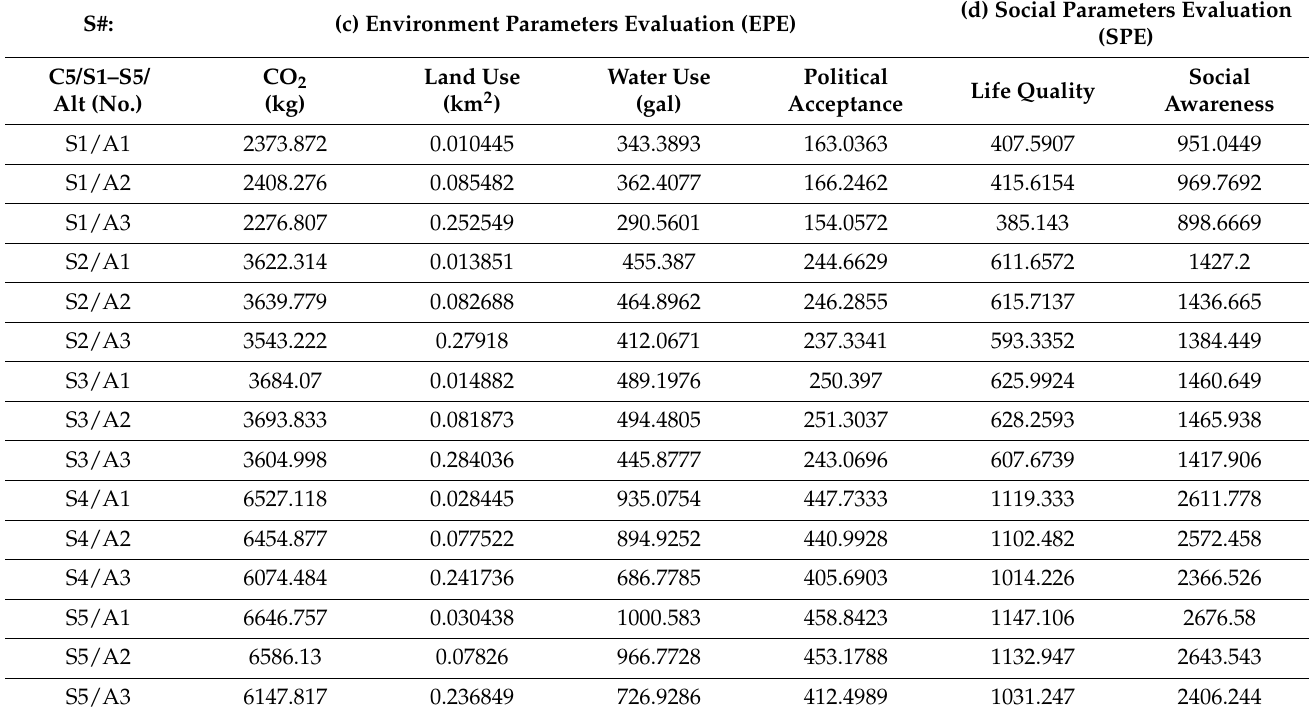
Table 23. EPE/SPE evaluations in C5/S1–S5 for the 75-bus MDN NUST_MG for DG